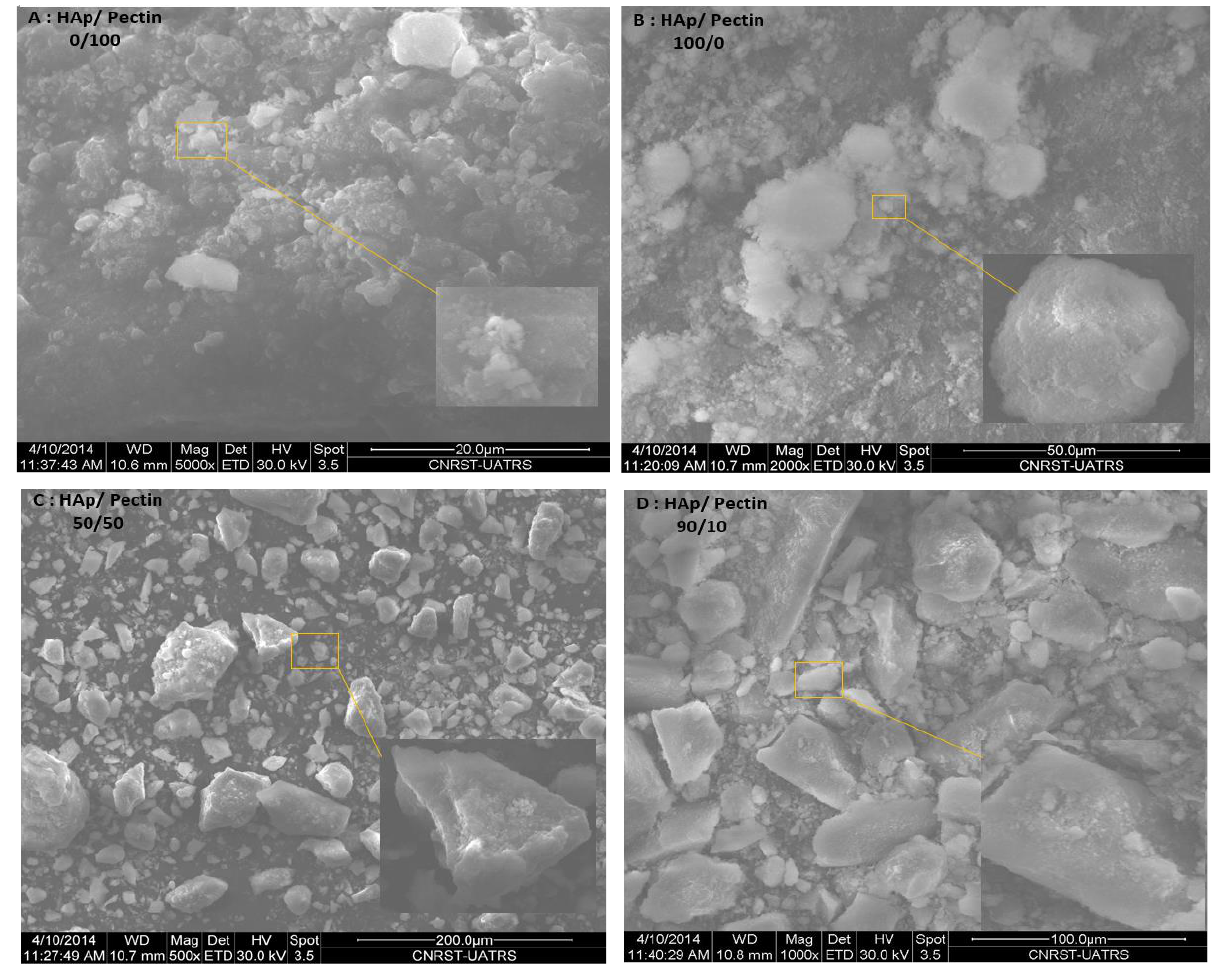
Figure 3. ( A ) SEM micrographs of pectin, ( B ) HAp, ( C ) HAp/pectin/50/50, and ( D ) HAp/pectin90/10